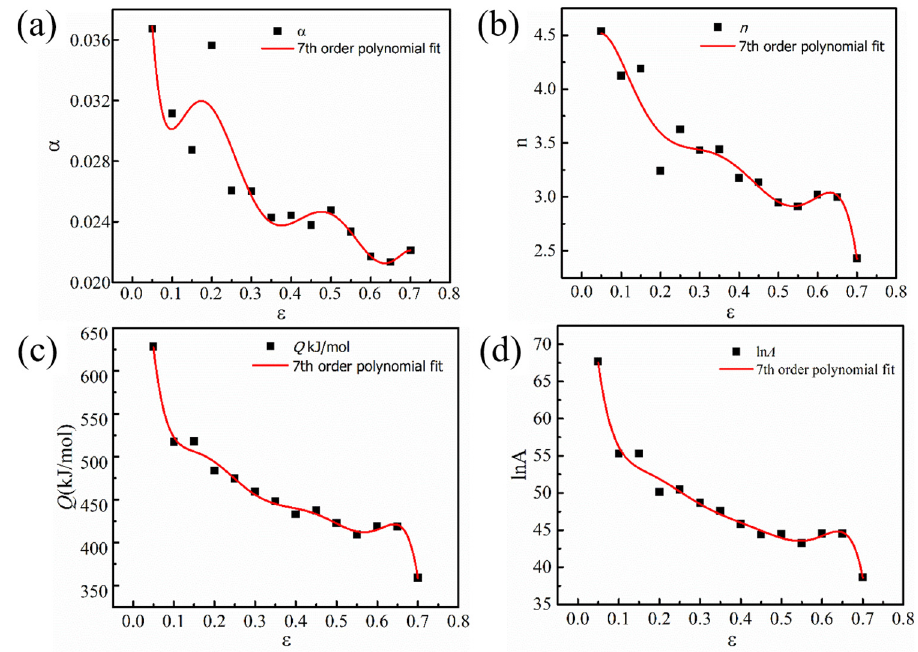
(14) Table 3. Data of material constants ( α , n, Q, and lnA ). α